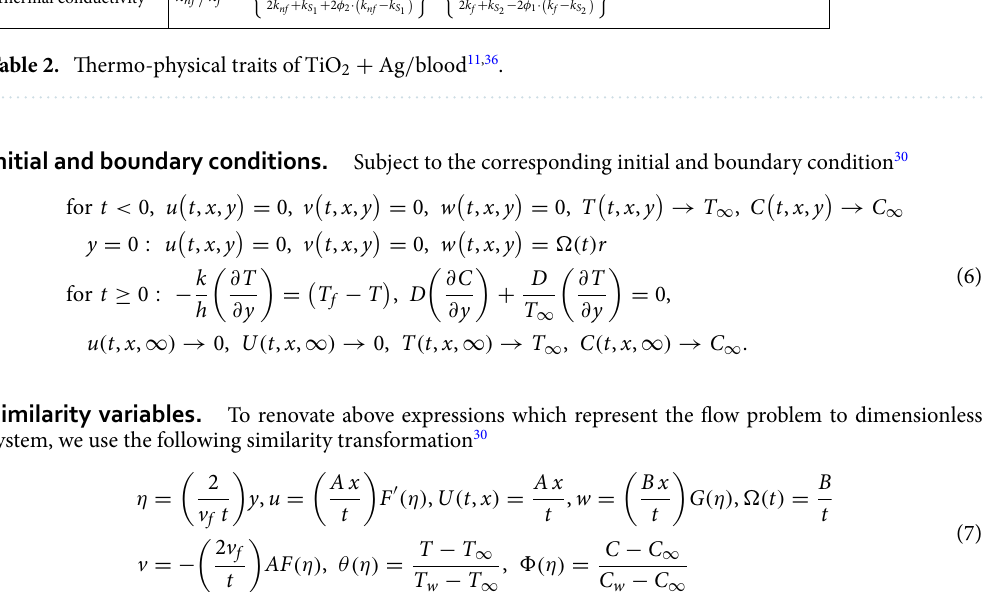
Specific heat Thermal